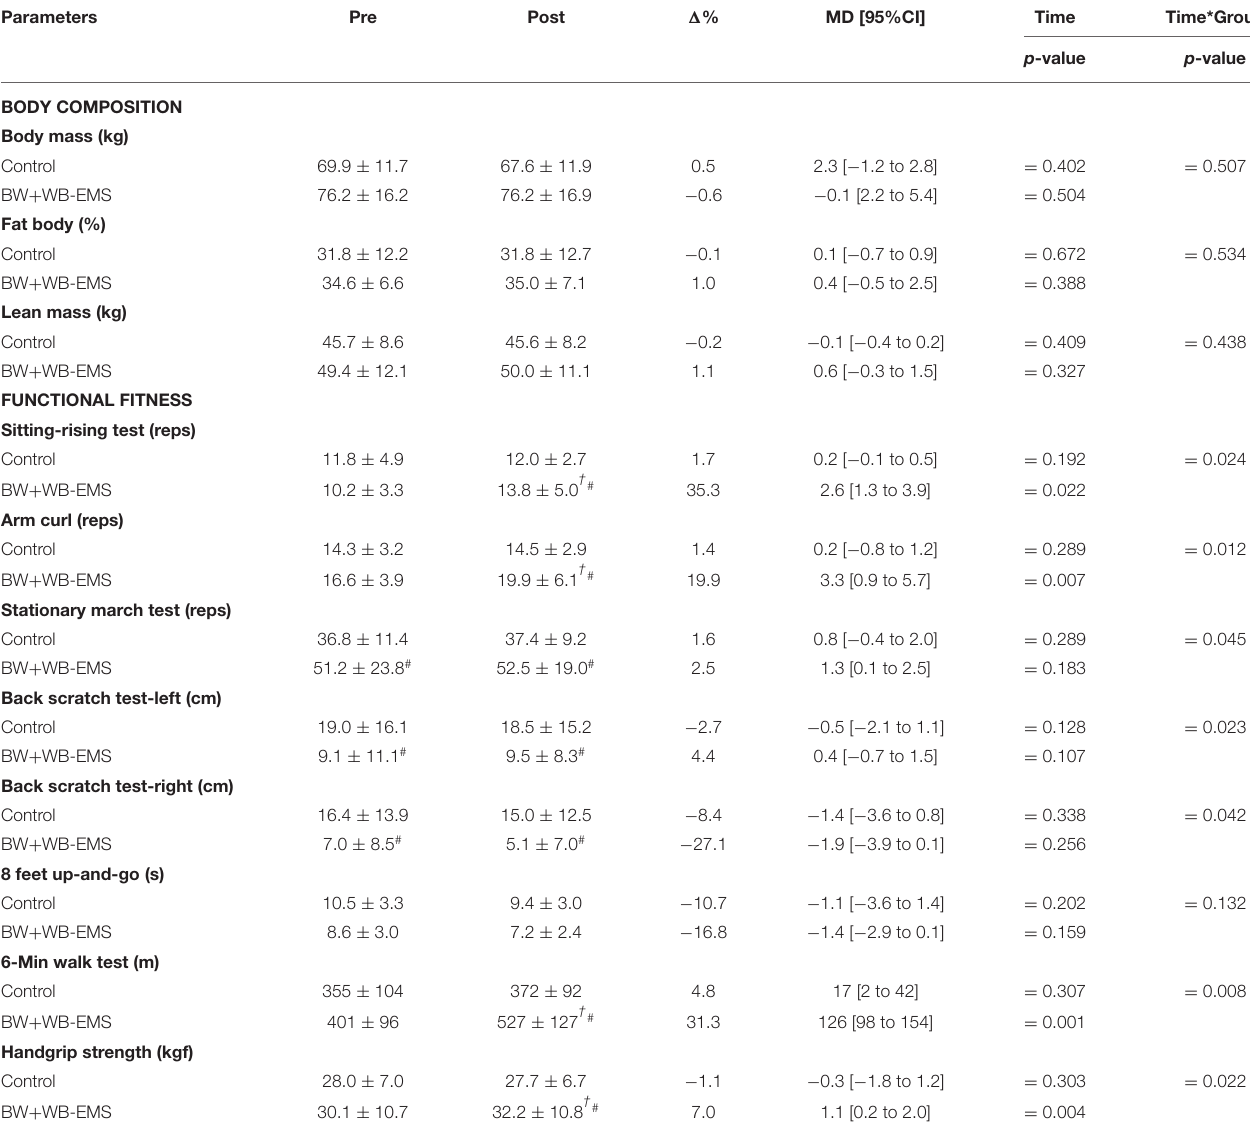
TABLE 2 | Alterations on body composition and functional fitness after 6 weeks of strength training combined with electrical muscle stimulation.